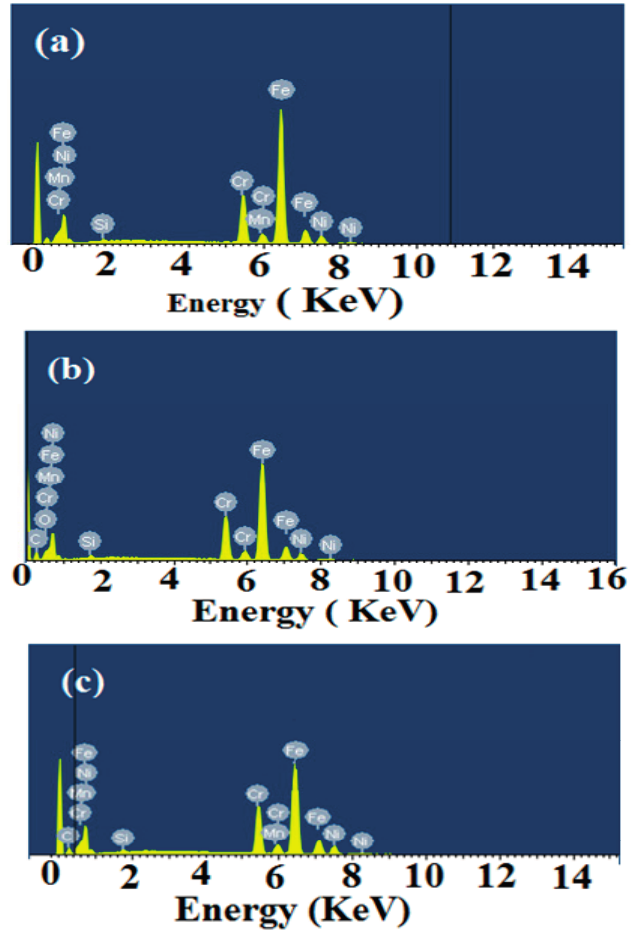
Figure 14. EDX analyses of ( a ) steel; ( b ) steel coated with 100 ppm of ODA-TS and ( c ) steel coated with 100 ppm of OA-TS after immersion in 1 M HCl aqueous